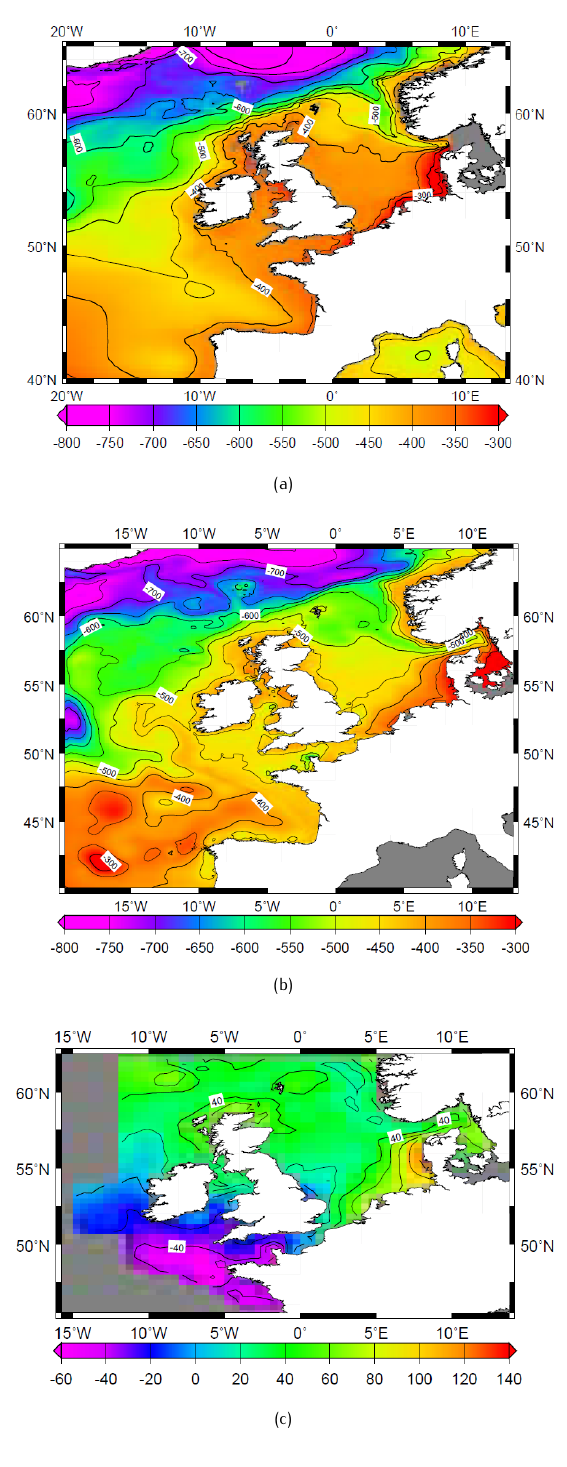
Figure 9. (a) MDT from the ‘fine grid’ Liverpool-MIT ocean model for the NW European Continental Shelf, (b) MDT from the POLCOMS regional model, and (c) variations in MSL from a tide+surge barotropic model. Each plot is for the decade 1993-2002. Units